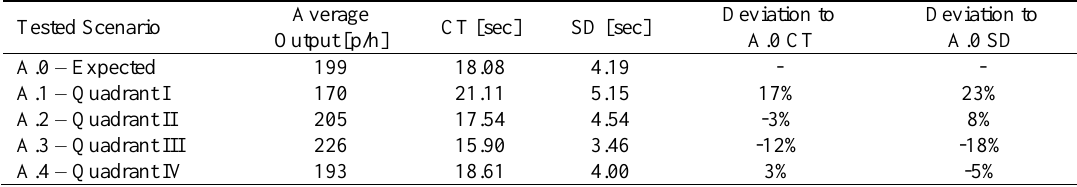
Table 4. Scenarios A results - 7 workers